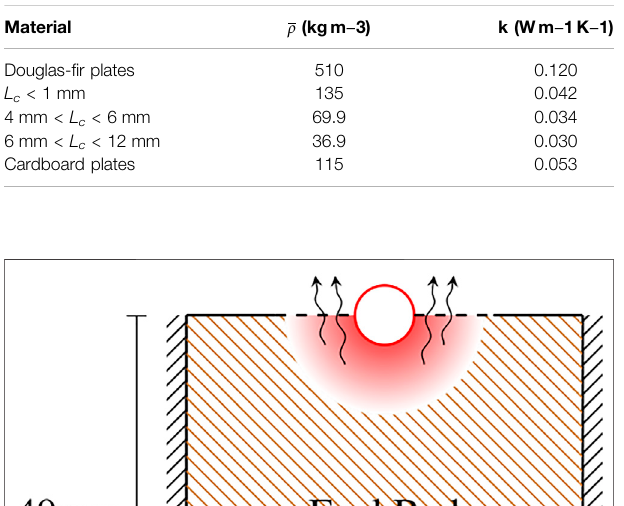
TABLE 1 | Measured ρ and estimated (k) fuel bed properties.